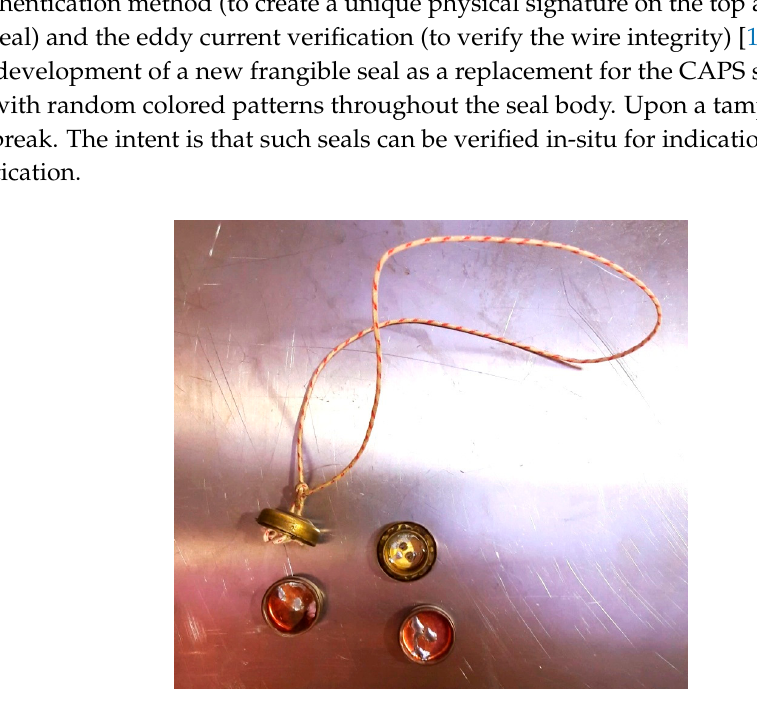
Figure 5. The Ultrasonic Sealing Bolt (USSB) structure and its application on underwater storage casks for nuclear